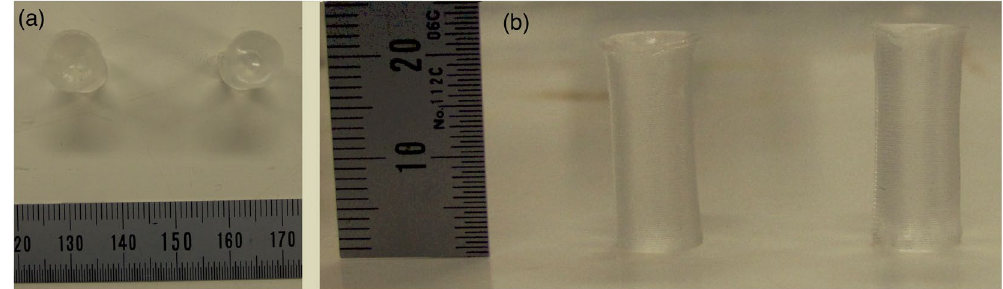
Figure 4. Photos of PVA-H specimens after gelation. ( a ) shows the top view and ( b ) shows side view. Left side in both figures shows the specimen ( e ) and right side in both figures shows the specimen ( a